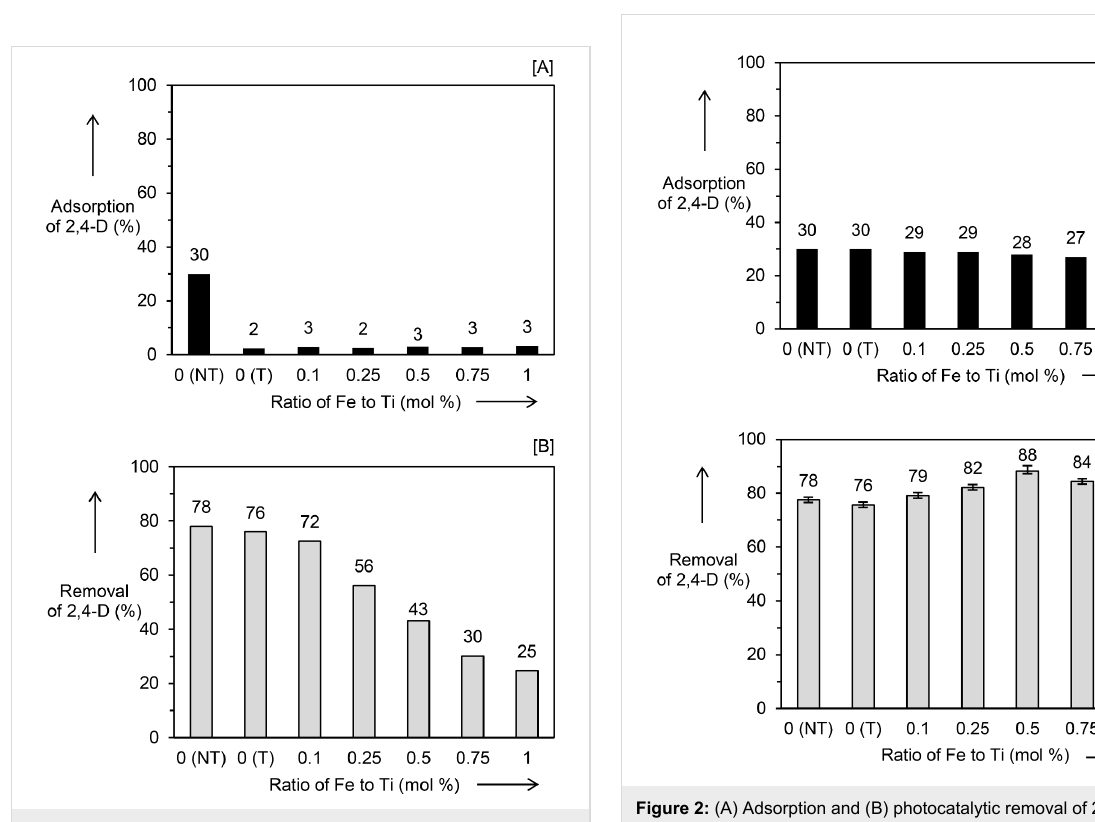
Figure 1: (A) Adsorption and (B) photocatalytic removal of 2,4-D using TiO 2 (NT), TiO 2 (IM_T) and series of Fe 2 O 3 /TiO 2 (IM). NT represents no treatment, IM shows the samples were prepared by impregnation method, and T indicates an additional heat treatment was carried out on the sample.